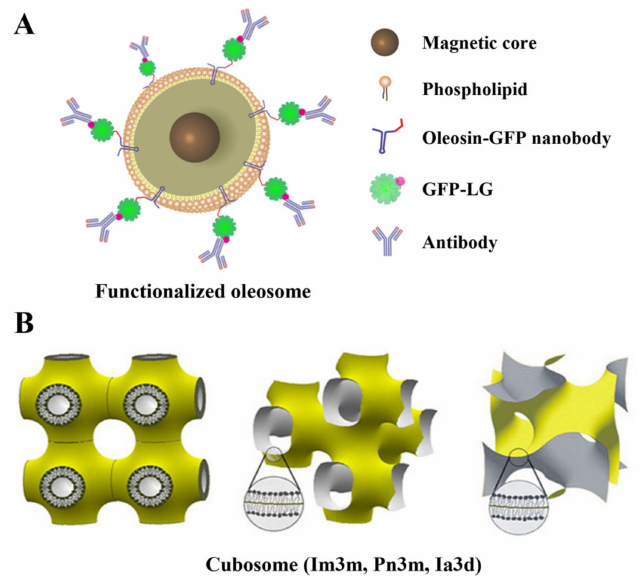
Figure 3. Newly proposed lipid nanoparticles-based drug delivery systems: ( A ) oleosome; ( B ) cubosome. Reproduced with permission from [50,54] and published by the American Chemical Society, 2015,